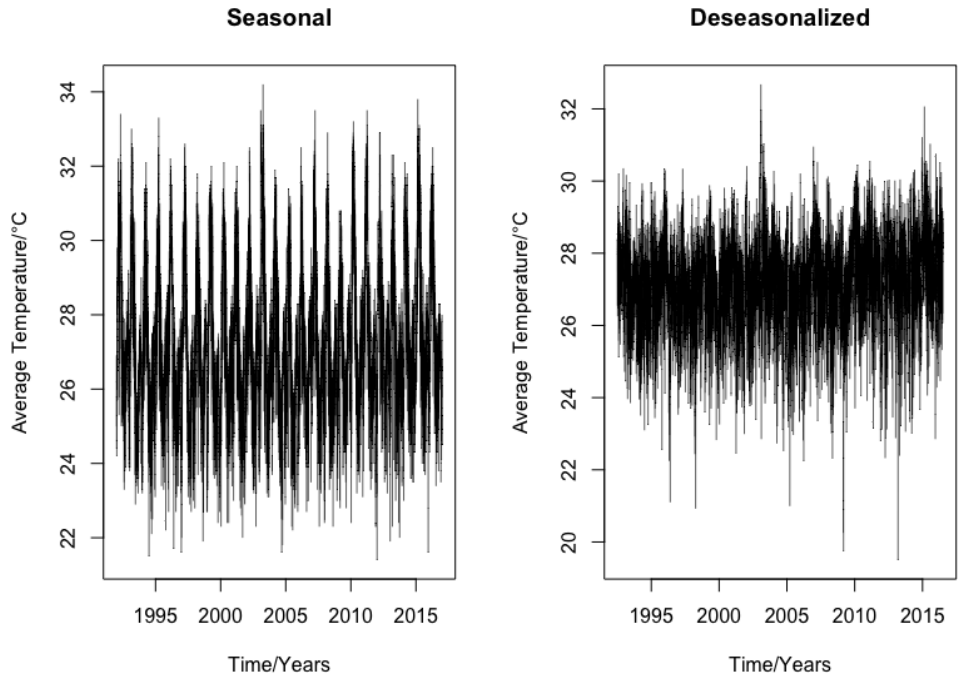
Figure 1. Seasonal and de-seasonalized daily average temperature of Bole.